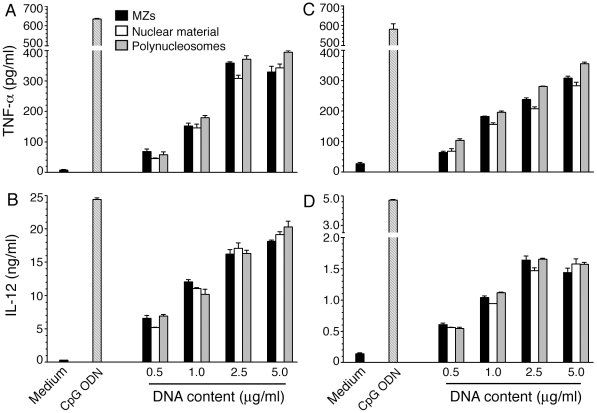
The nuclear material and polynucleosomes of P. falciparum efficiently activate DCs to produce inflammatory cytokines.FL-DCs (panels A and B) or spleen DCs (panels C and D) from WT mice were plated in 96-well plates and stimulated with the indicated doses (based on DNA contents) of nuclear material or polynucleosomes. FL-DCs similarly stimulated with merozoites (MZs, dose indicated by DNA content) or with a standard CpG ODN were analyzed as controls. The levels of TNF-α and IL-12 in the culture medium were measured by ELISA. Data are representatives of three independent experiments, each performed in duplicates. Error bar represents mean values ± SEM.